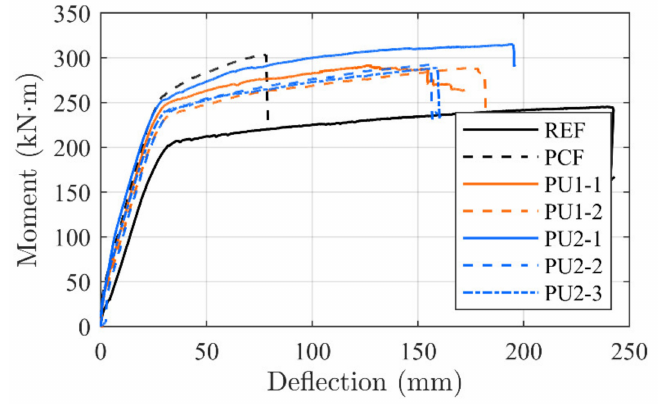
Figure 9. Moment–deformation test